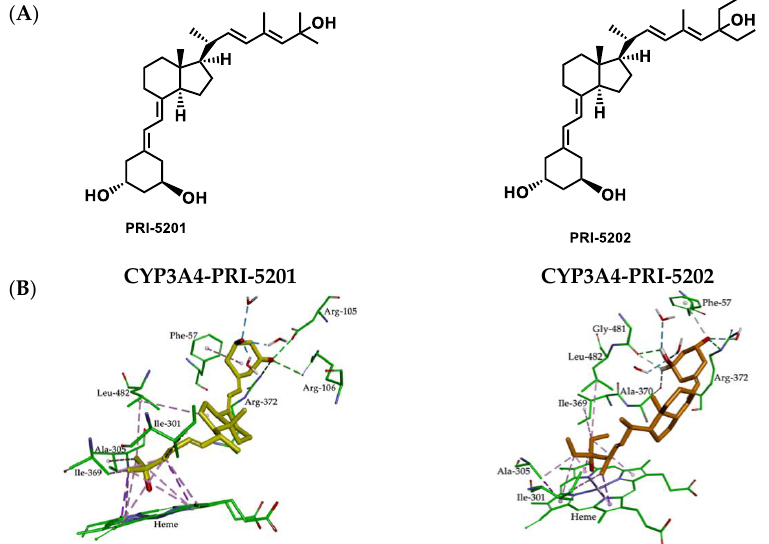
Figure 6. ( A ) Structural formulas of the analogs of 1 α ,25-dihydroxyvitamin D 2 (PRI-5201 and PRI-5202). ( B ) Molecular interactions between 1,25D2 analogs (PRI-5201 and PRI-5202) and CYP3A4 resulting from MD simulations. Hydrophobic interactions are shown as magenta dashed lines and hydrogen bonds as green.